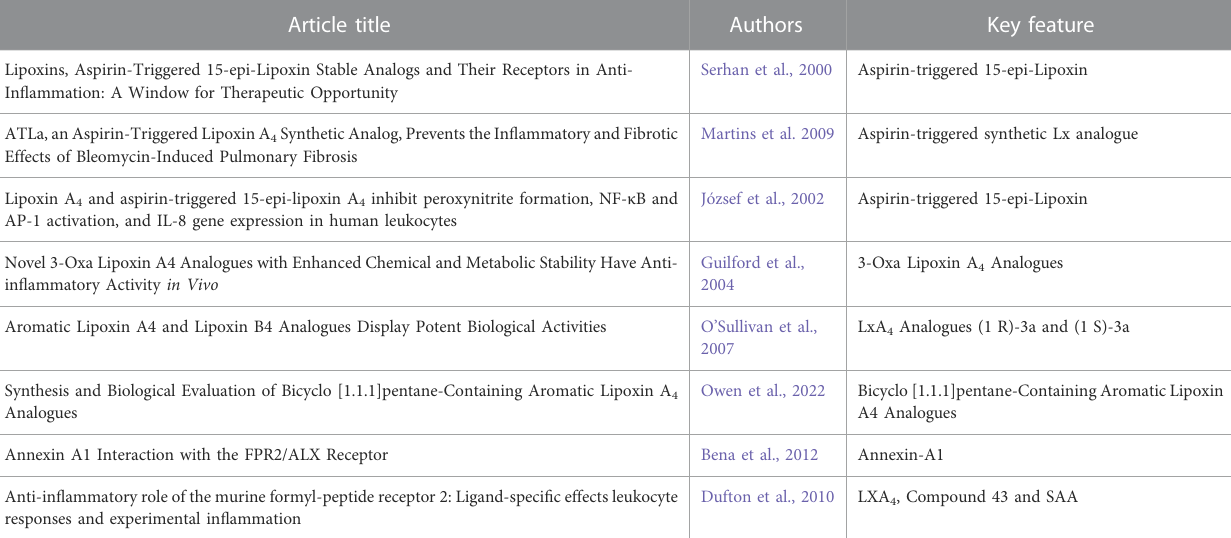
TABLE 1 Key Publications Discussing the Anti-in fl ammatory Properties and Functions of sLXms and the FPR2